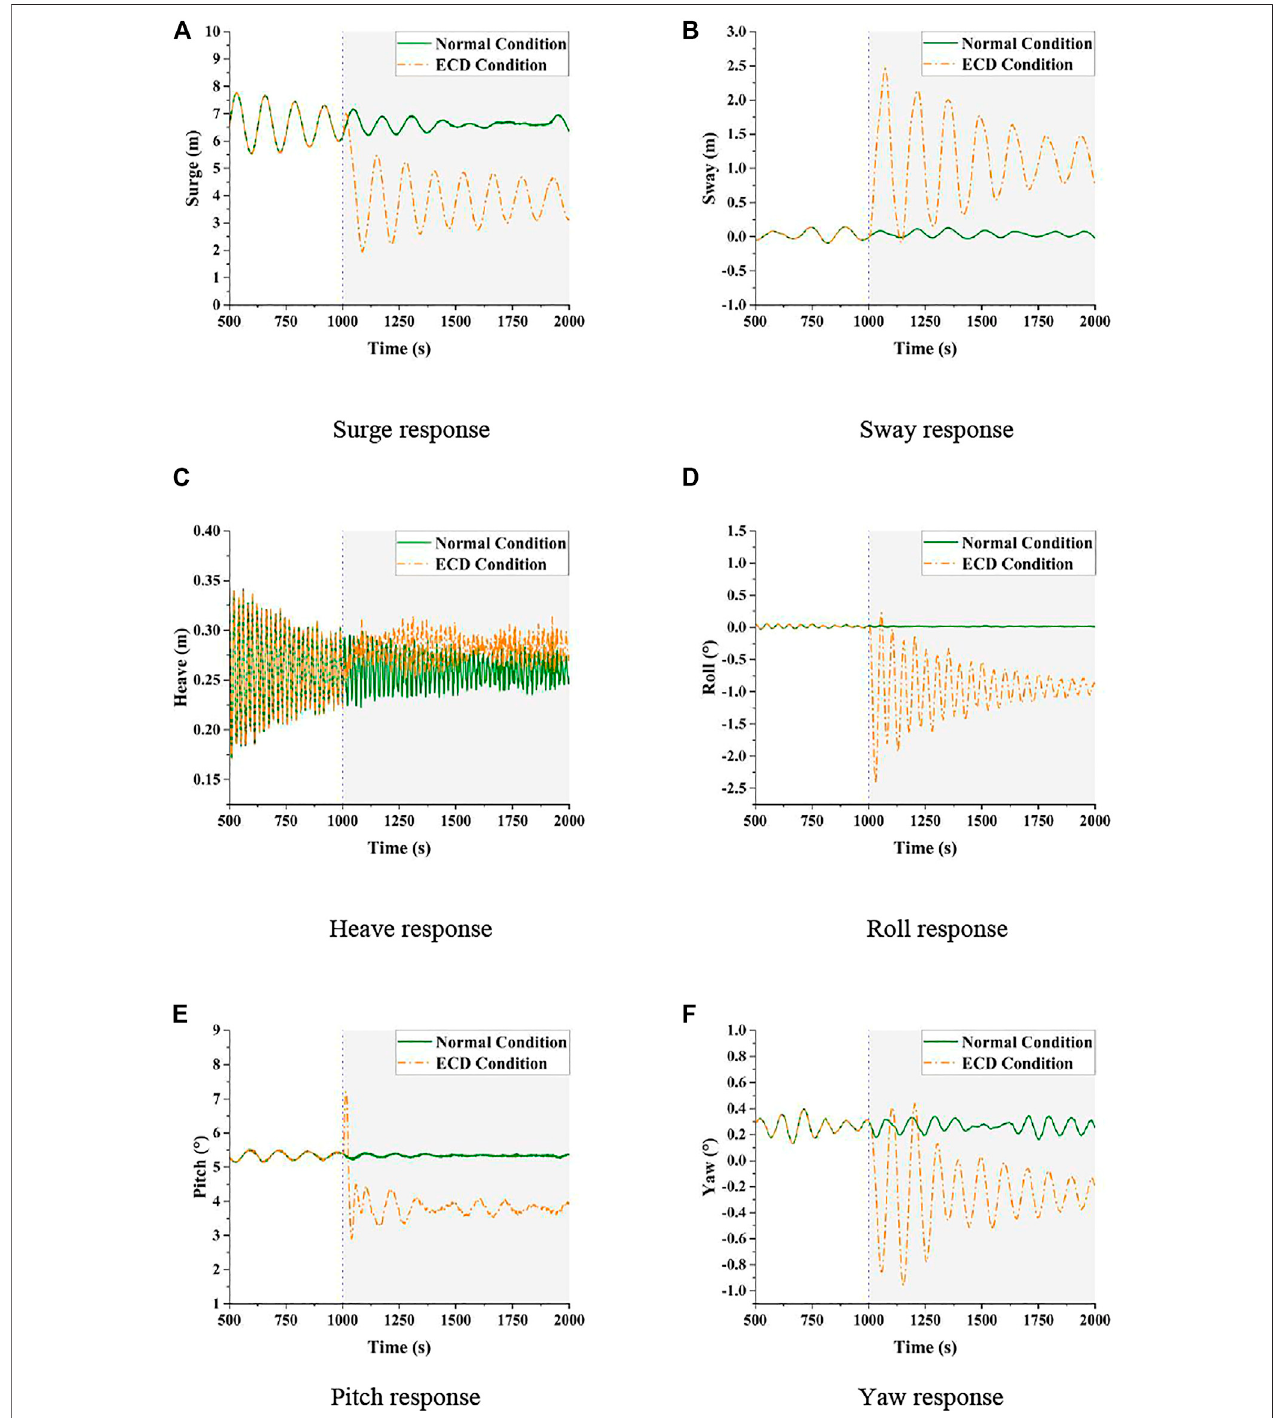
FIGURE13| Motion response ofthe15 MW FOWTunder thenormal conditionand ECDcondition. (A) Surge response. (B) Swayresponse. (C) Heave response. (D) Roll response. (E) Pitch response. (F) Yaw response.